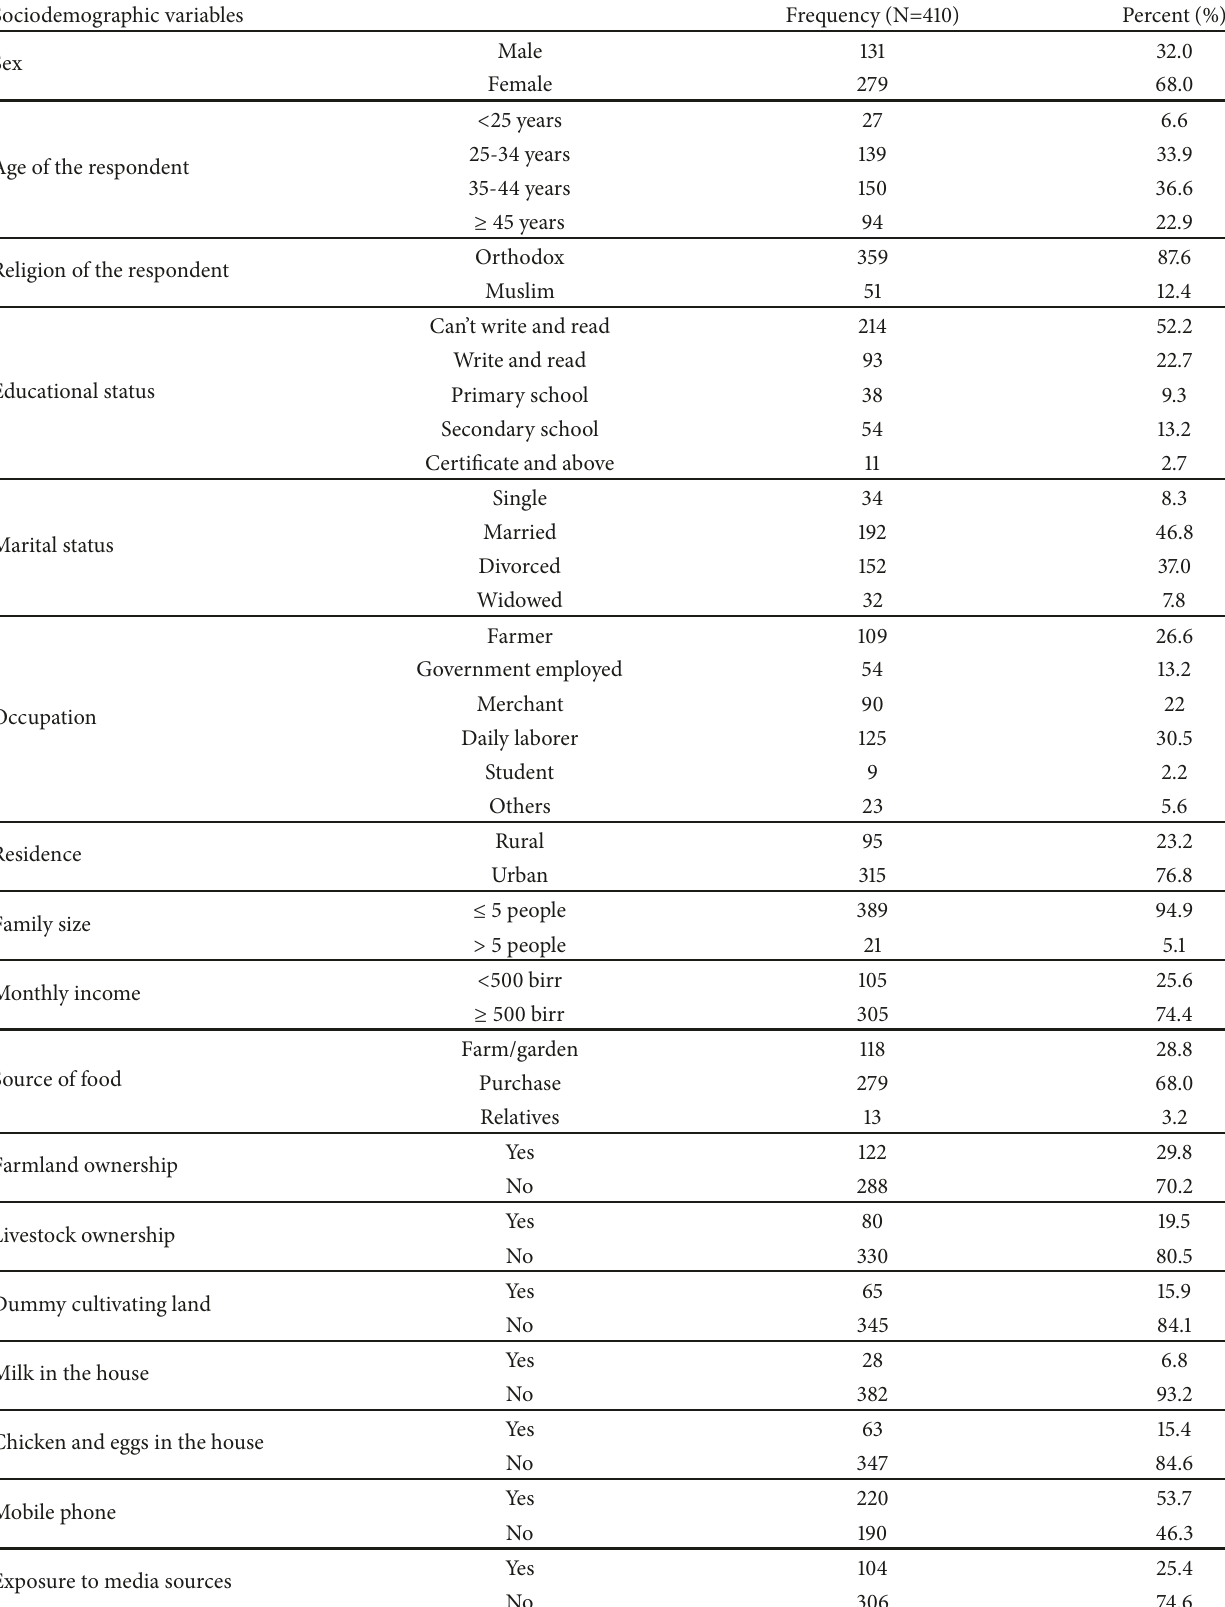
Table 1: Sociodemographic characteristics of adult HIV positive patients in Motta administrative town ART sites, April, 2017. Sociodemographic